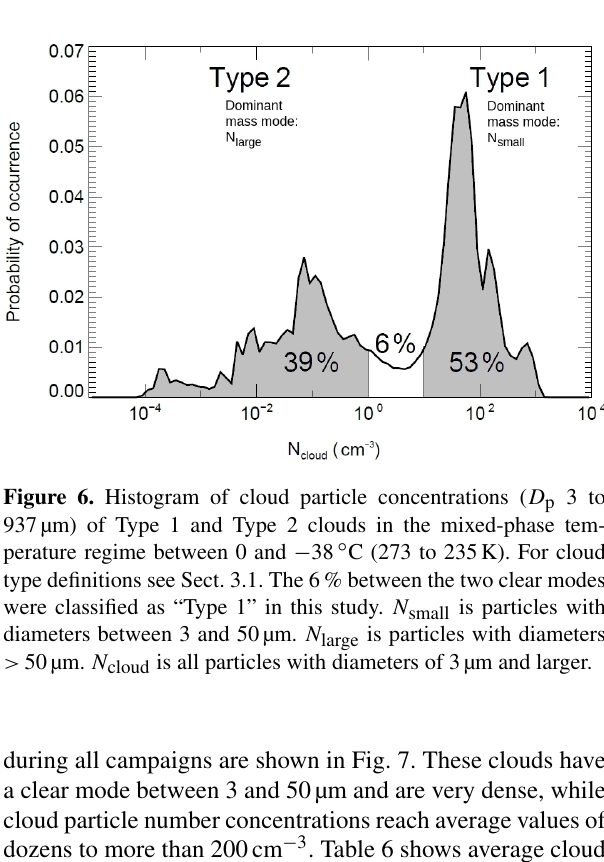
Figure 5. Upper panel: size distributions along time during flight 08 of the VERDI campaign (colour code: d N / dlog D p ). Two types of cloud can be distinguished; one is dominated by the large particle mode (Type 2, example in lower a ), the second by small particles (Type 1, example in lower b ). The two cloud types are also associated with strongly differing particle number concentration ranges; see Fig. 6.